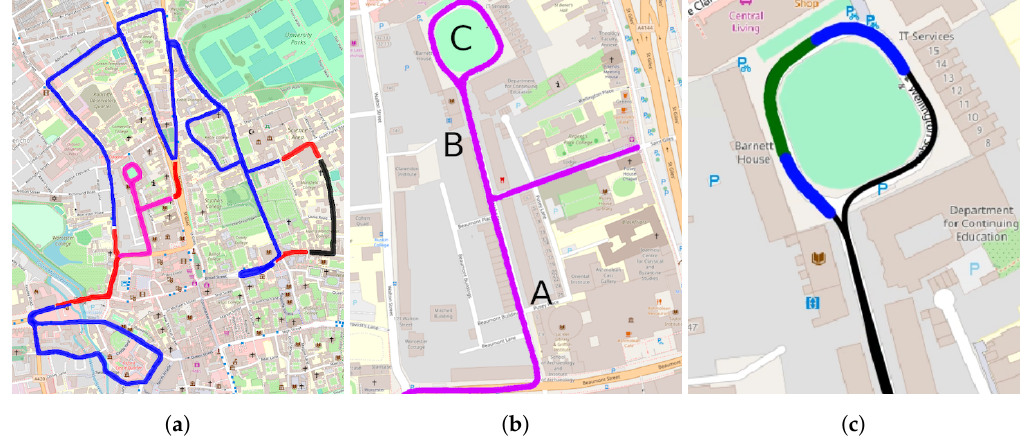
Figure 7. ( a ) train (blue), valid (black), and test (magenta) splits of the full Oxford Radar RobotCar Dataset . Red portions serve as padding between splits to account for the long range of the radar. ( b ) Example of test split for one of the traversals. A and B are straight portions which look very similar, while C is a very uniform-looking roundabout; these properties are represented in the embedding distance (c.f. Figure 8). Moreover, B is driven twice, in the two opposite directions. The true positive boundary (c.f. Section 5.2) is shown green in ( c ). This 25m threshold is deemed suitable even in tight roundabouts, such as this, where a larger boundary (blue) would make the location of the vehicle in this tight turn